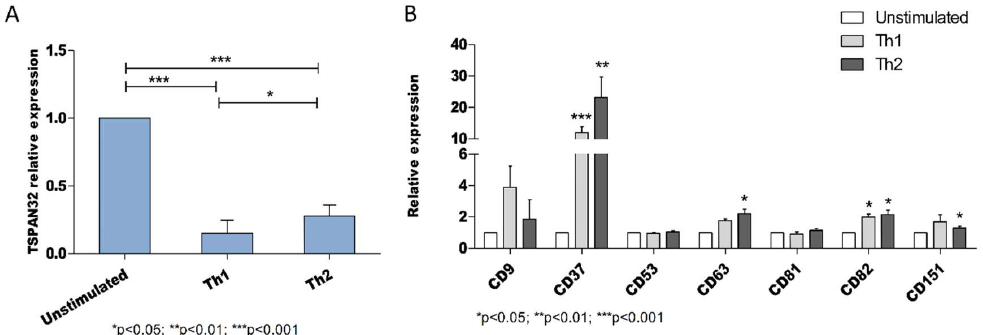
Figure 3. Expression of tetraspanins in human T cell polarization. ( A ) Expression of TSPAN32 was evaluated by real-time PCR in polarized Th1 and Th2 cells and unstimulated cells ( n = 3 independent replicates). ( B ) Expression of CD9, CD37, CD53, CD63, CD81, CD82 and CD151 in polarized Th1 and Th2 cells and unstimulated cells as evaluated by real-time PCR ( n = 3 independent replicates). Data are shown as normalized mean ± SD and statistical analysis performed using one-way ANOVA followed by Bonferroni multiple test correction.